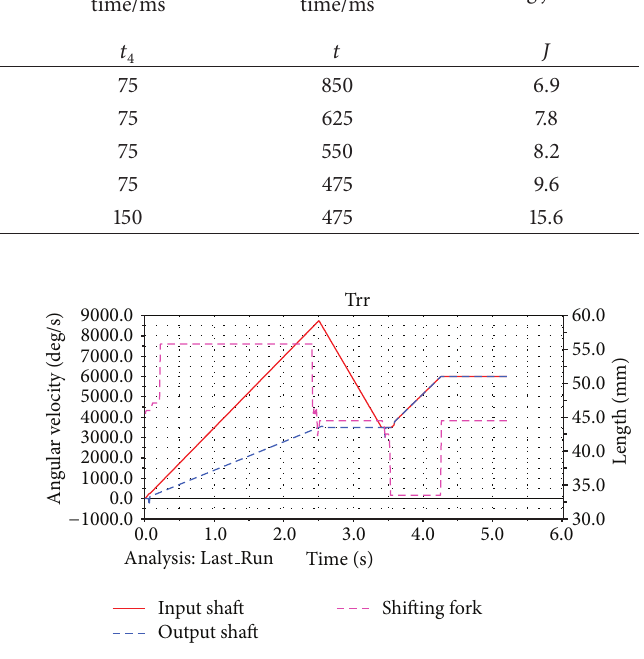
Figure 9: Simulation results of EMT shifting